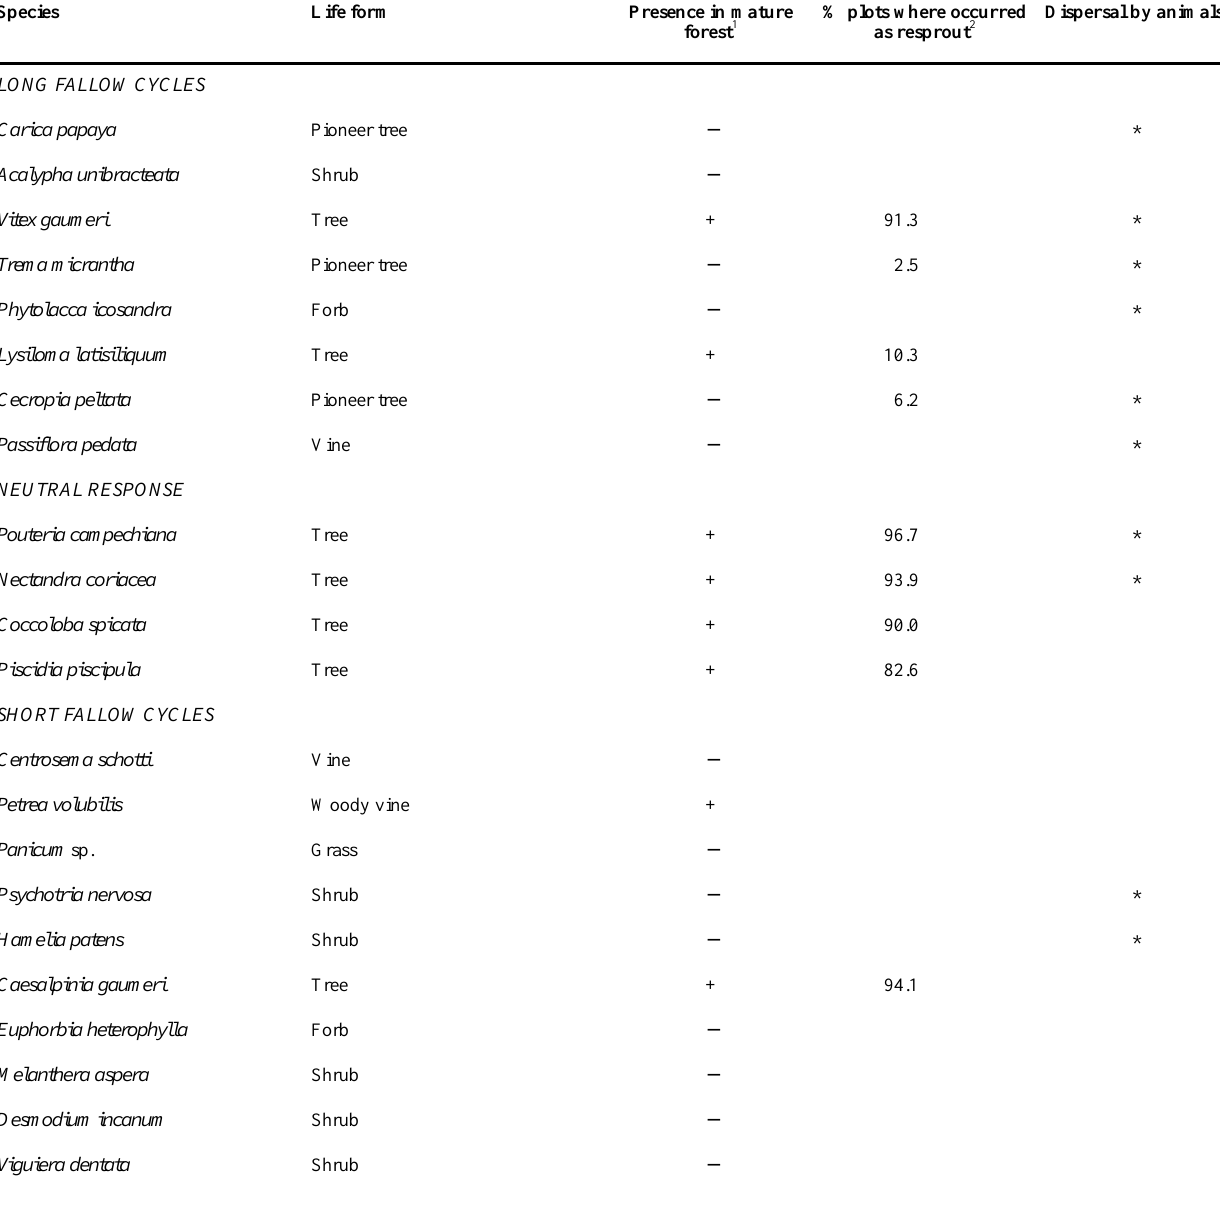
Table 5. Summary of species’ responses to fallow history, and associated characteristics. Note that species are arranged from those most strongly associated to long fallow cycles at the top ( Carica papaya ) to those most strongly associated to short cycles ( Viguiera dentata ) at the